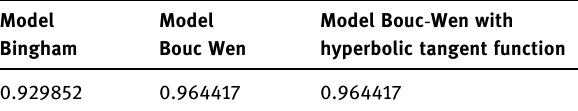
Table 4: Similarity measure, s ( models and SMC damping force )